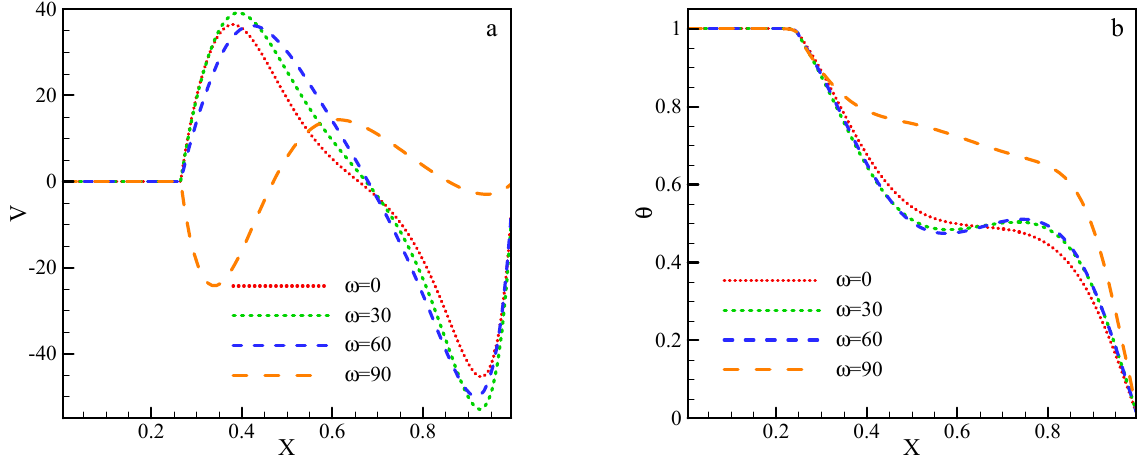
Figure 14. Dimensionless velocity ( a ) and dimensionless temperature ( b ) at Y = 0.5 for Ra = 10 5 , Rd = 1, Ha = 20, AR = 0.45 − 0.6, γ = 45, ϕ = 0.03, and different cavity